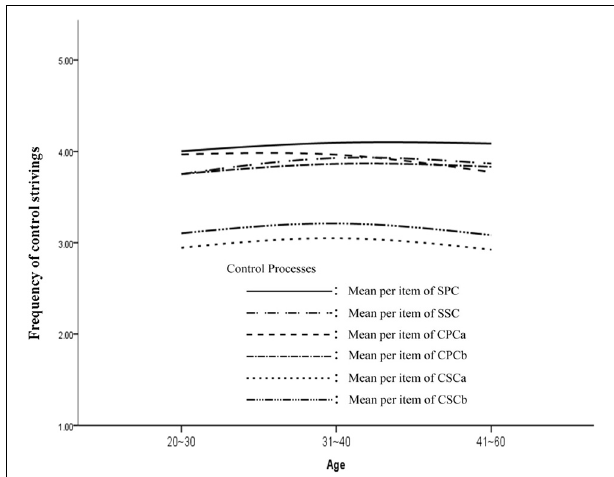
FIGURE 1 | The life-span trajectories of control strivings among the Chinese teachers. SPC, selective primary control; SSC, selective secondary control; CPCa, compensatory primary control (Type a); CPCb, compensatory primary control (Type b); CSCa, compensatory secondary control (Type a); CSCb, compensatory secondary control (Type b); OG, general optimization; OT, optimization in the domain of